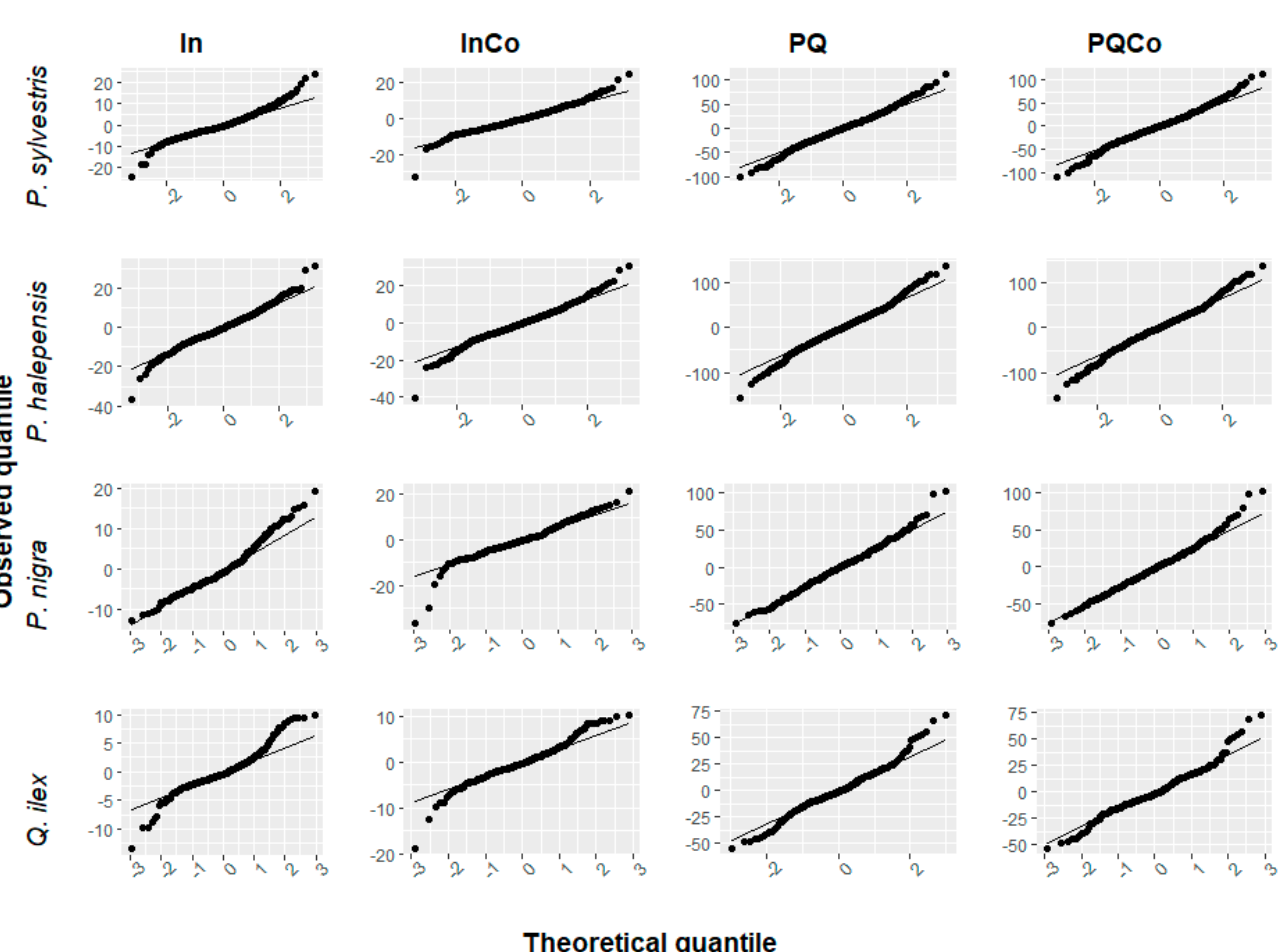
Figure A2. Diagnostic plots (qqplots) of the linear model for observed DBH4 vs. predicted DBH4 for each aggregation level (individual (In) and plot-quantile classes (PQ)), two Equations (1) and (2) (Co for competition), and four species ( Pinus sylvestris , P. halepensis , P. nigra , and Quercus ilex ).